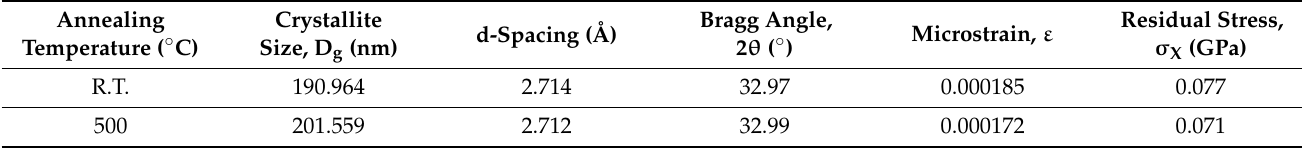
Table 2. The results of XRD at the <104> crystal plane.